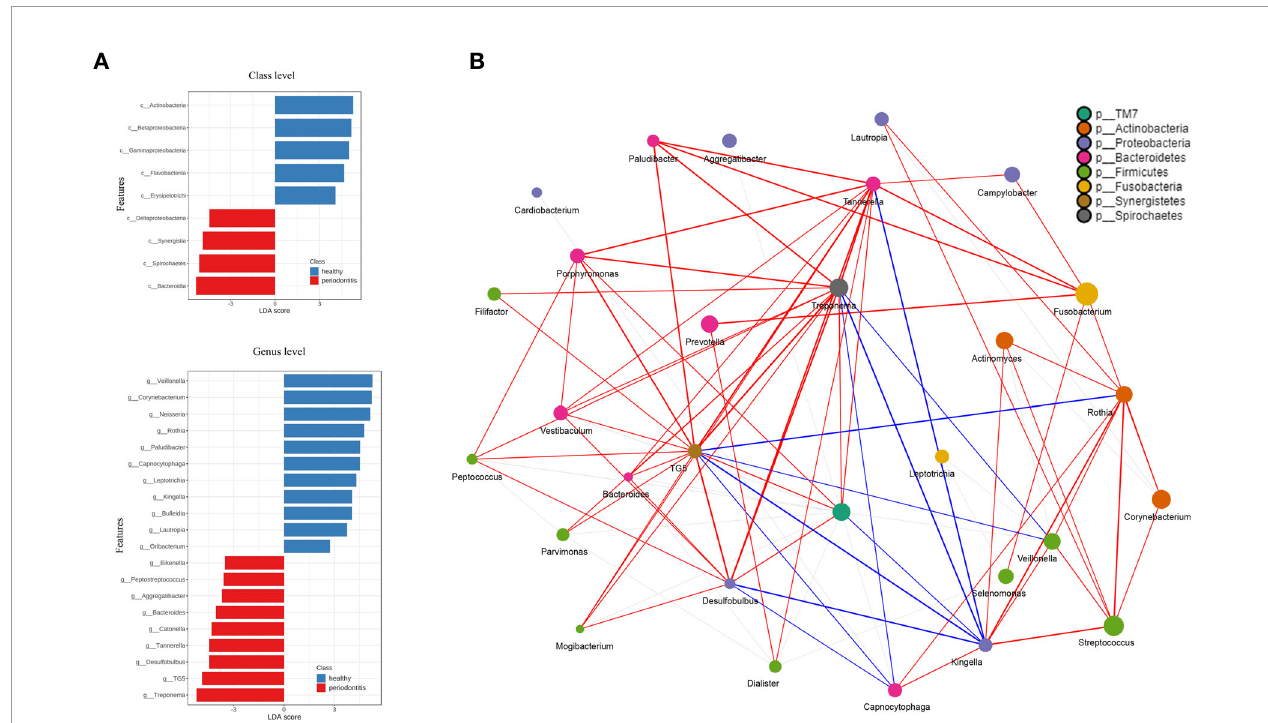
FIGURE 3 | (A) The ordinate is the taxa with signi fi cant differences between the groups, and the abscissa is a bar graph to visually display the LDA analysis logarithmic score value of each taxa. The longer the length, the more signi fi cant the difference in the taxon. Red bars indicate periodontitis and blue bars indicate healthy control. (B) The network analysis shows the correlation between microorganisms on the genus level. Each genus is colored according to its phylum. The edges show greater correlations and the node size re fl ects the abundance. Red and blue lines represent positive and negative correlations,